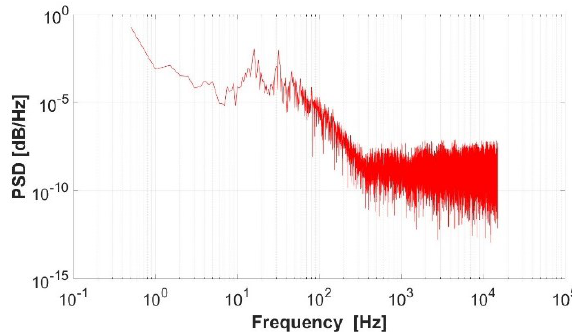
Fig. 3. Example of two strong frequencies behind the single circular